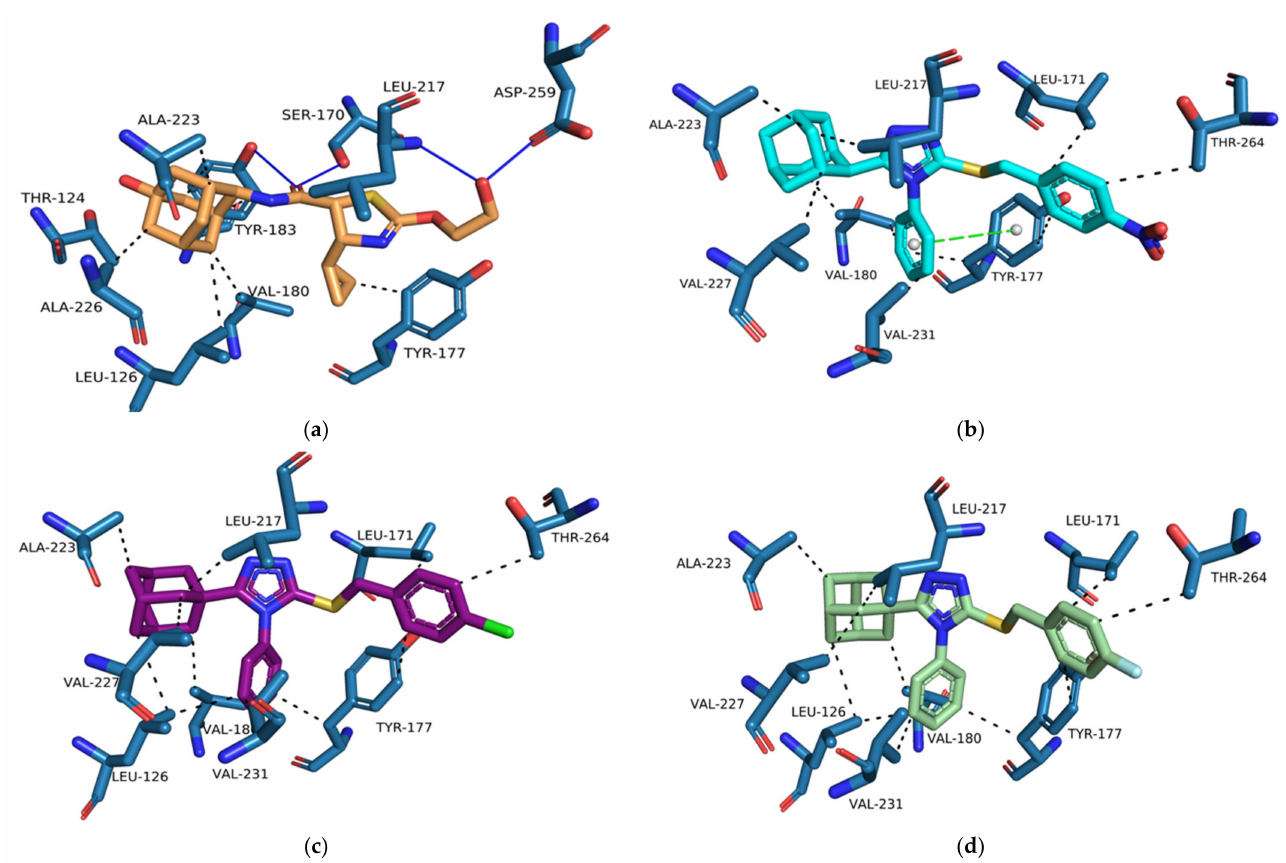
Figure 11. The binding orientations and interactions of 4YQ ( a ) and compounds 1 ( b ), 2 ( c ) and 3 ( d ) within the 11 β -HSD1 active site were analyzed on PLIP [48] and visualized using Pymol molecular graphics system. The hydrogen bond and hydrophobic interactions are indicated by the solid blue and black dashed lines